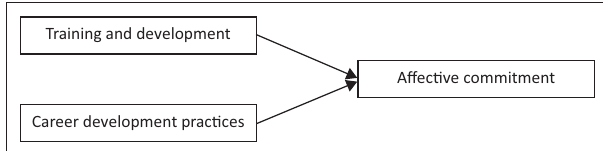
FIG URE 1: Conceptual model of the study